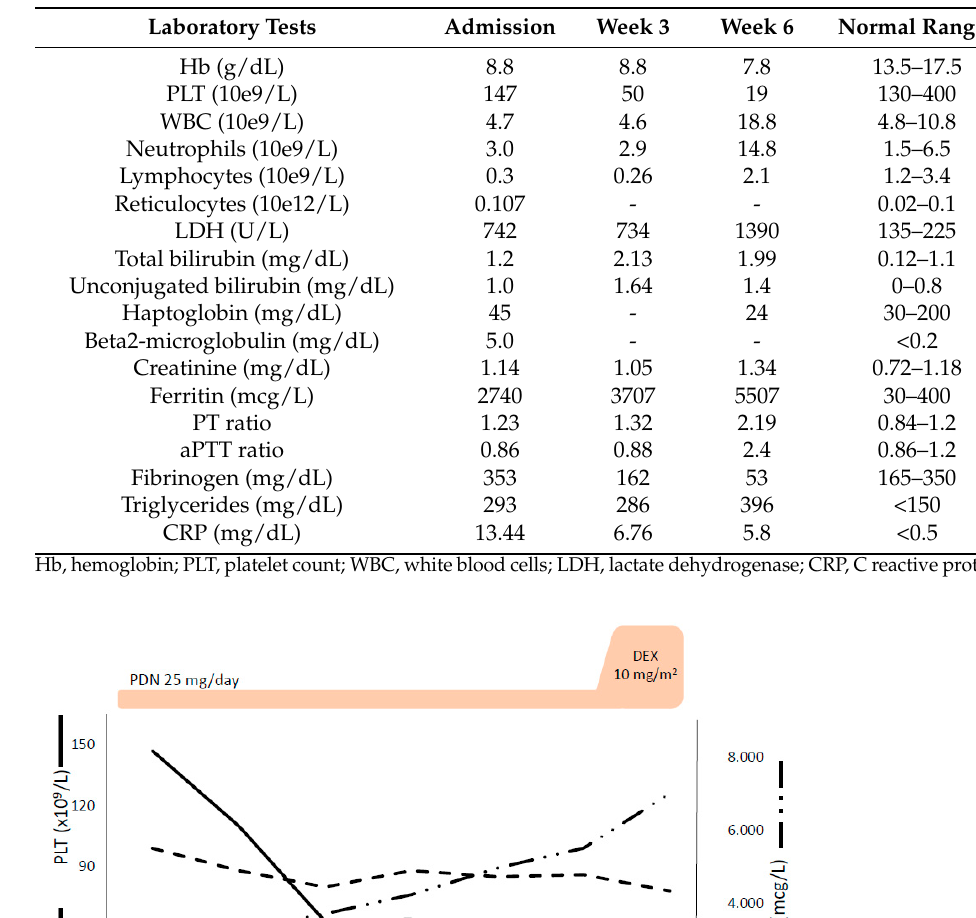
Table 3. Laboratory exams of Patient #2.